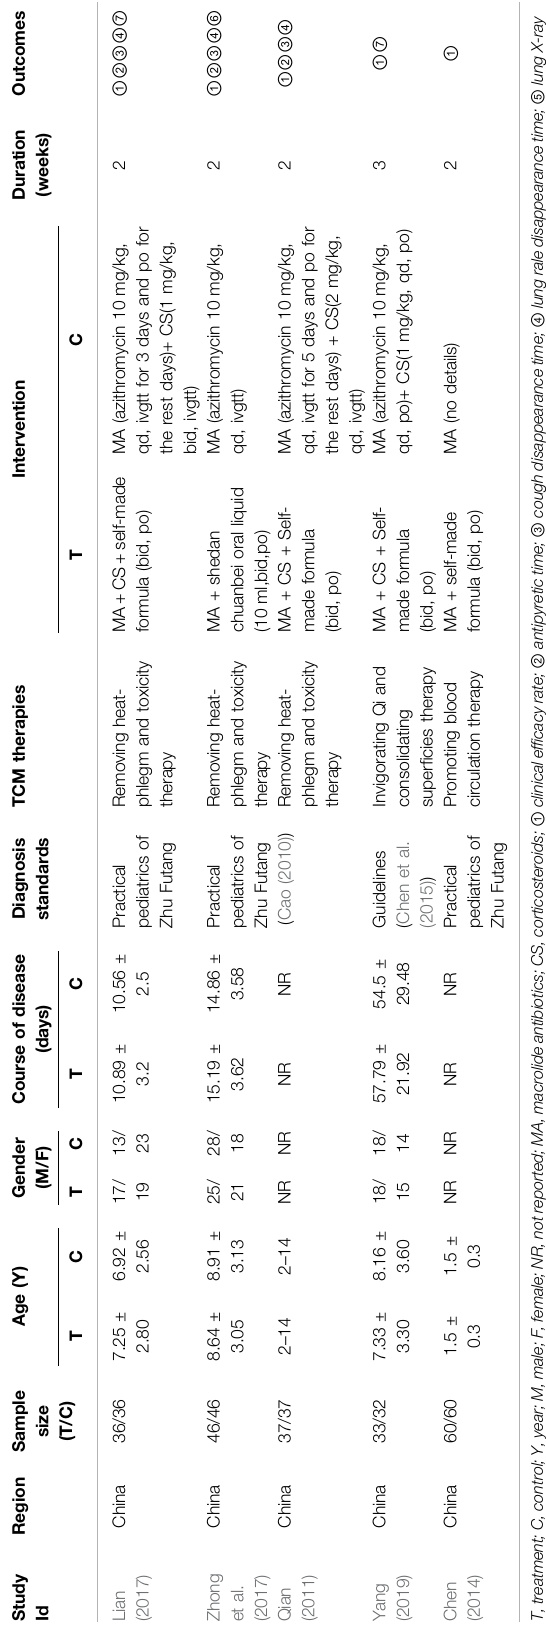
( Figure 4B ). In subgroup analysis ( Table 2 ), TCM therapy of removing heat-phlegm and toxicity was more bene fi cial than invigorating Qi and consolidating super fi